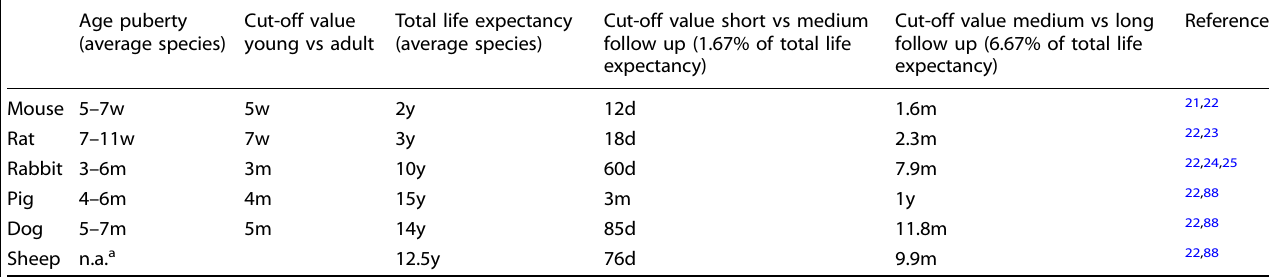
Table 1. Species-dependent subcategorization of age and follow-up time for data mapping and meta-analysis. Age puberty Cut-off value Total life expectancy (average species) young vs adult (average species)